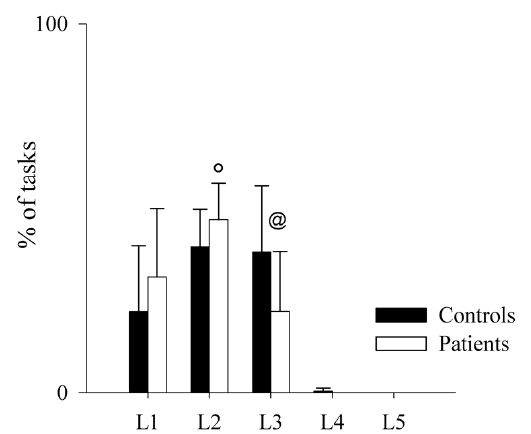
Figure 5 . Comparison of the performance on the MIST test in healthy controls and PAH patients. The bar graphs show the percentage of tasks in each level of di ffi culty during the MIST session in healthy controls (black bars) and PAH patients (white bars). Level 1 (L1) is the easiest, while Level 5 (L5) is the most di ffi cult one. Results are presented as mean ± standard deviation. @ indicates p < 0.05 controls vs. patients, and ° indicates p < 0.05 Level 3 vs. Level 2 in patients.